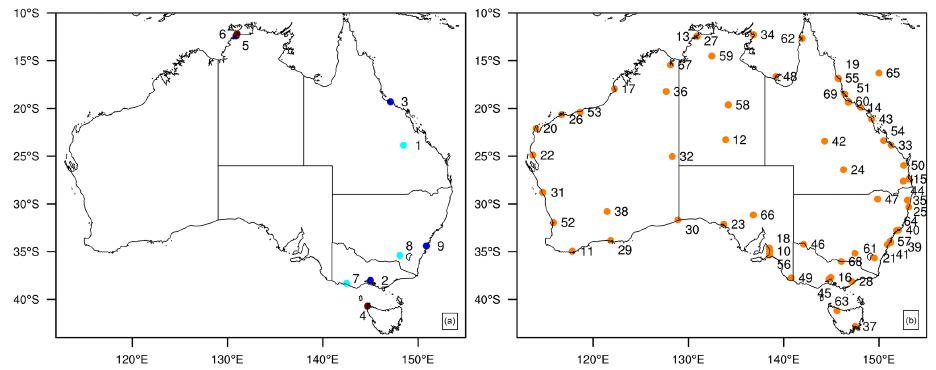
Figure 4. Location of the existing GHG measurement stations in Australia (a) and potential sites using mainly the location of the stations in the Bureau of Meteorology’s National Radar Loop (b) . Station names are provided in Table 1 for existing sites and Table 2 for potential sites. In (a) existing stations that are included in the base network are marked in brown, and stations that are no longer operational are marked in light